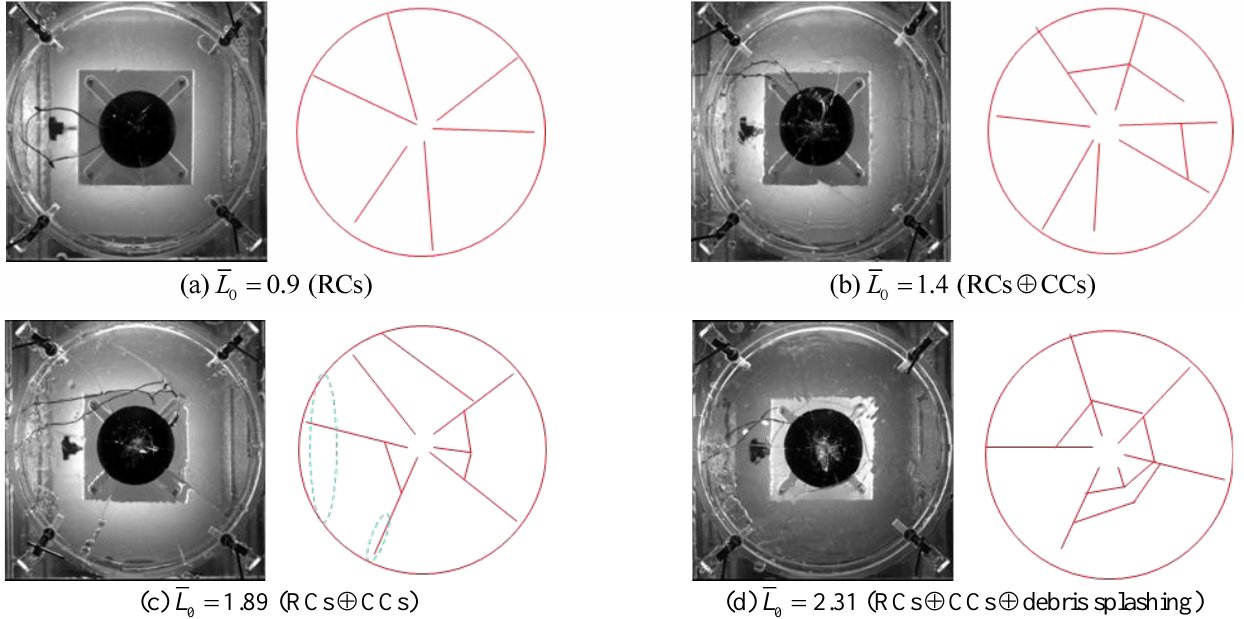
Figure 10. Typical damage patterns of ice plates with different L 0 , as denoted in the subfigures, with the initial condition of ρ = 0.6 and h = 0.071 at t (cid:48) = 0.1 s.